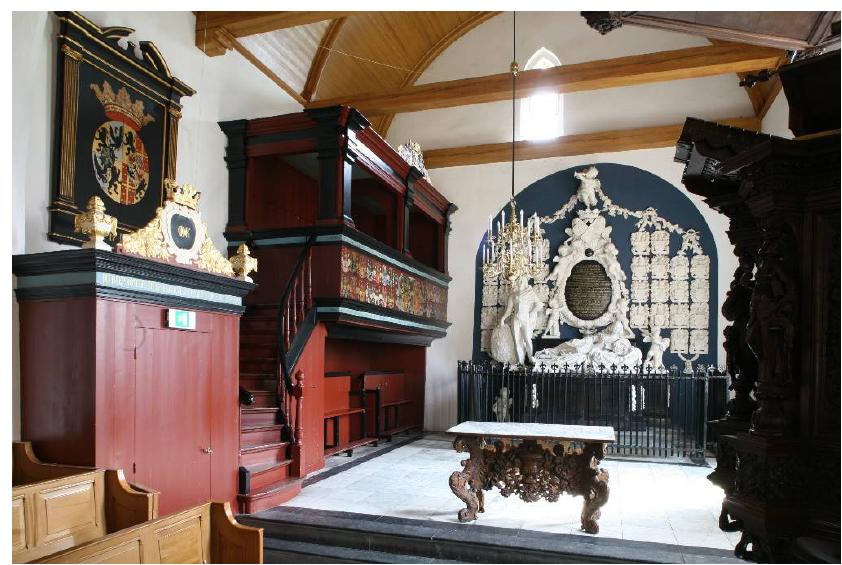
Figure 5. Midwolde (Groningen), interior looking east with an elevated pew (left) and a marble tomb filling the chancel (photo: Regnerus Steensma archive).